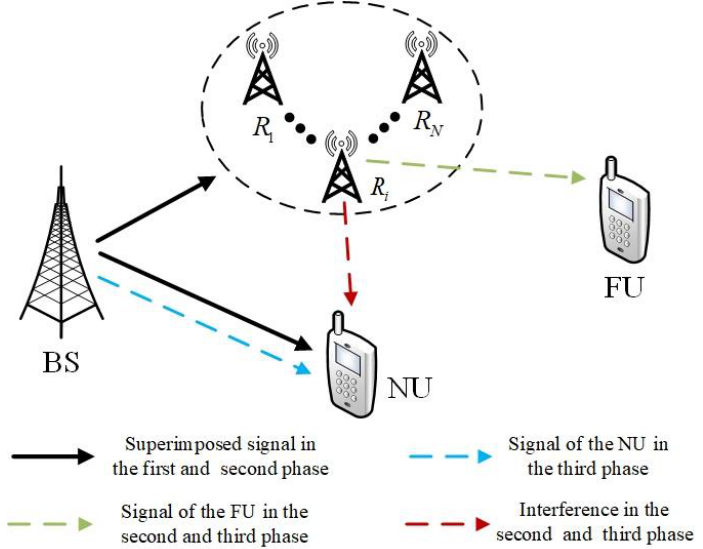
Figure 1. System model for 3 −